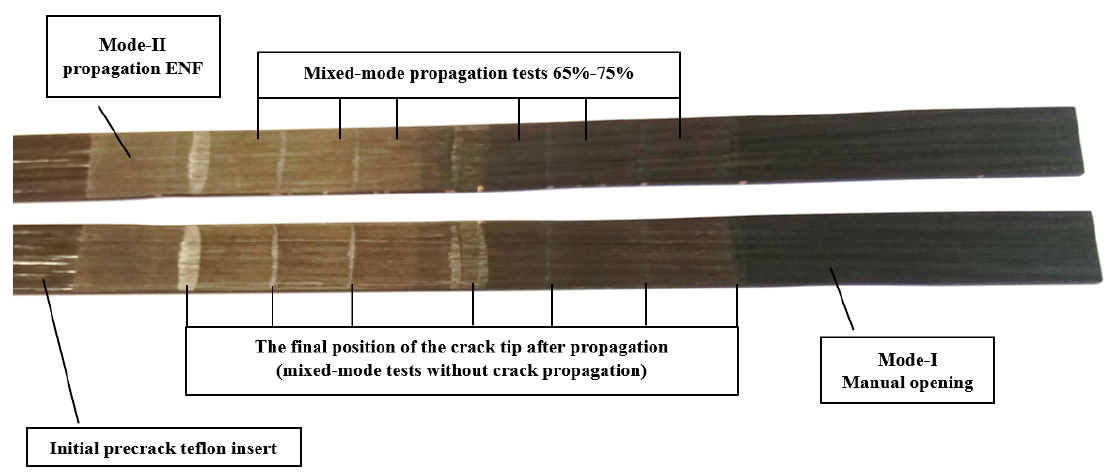
Figure 11. Specimen open for micrography examination.